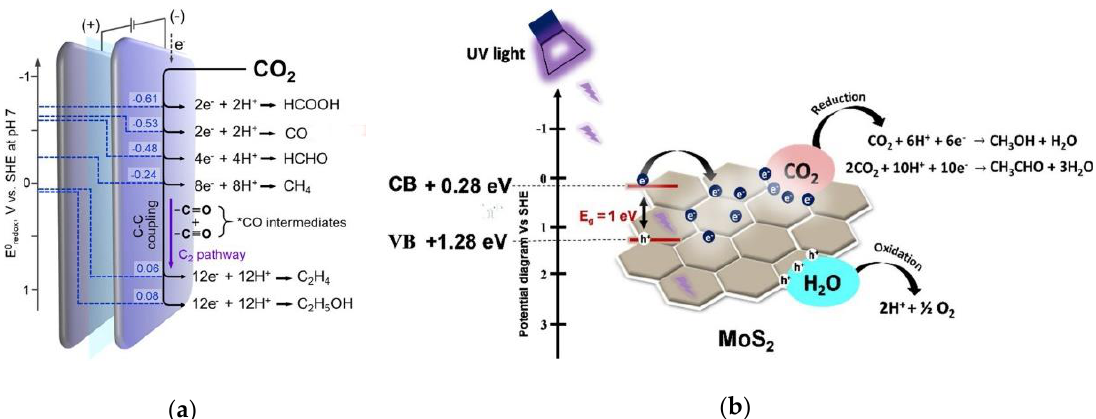
Figure 10. ( a ) Scheme of the electrochemical conversion of CO 2 into value-added chemicals (Reproduced with permission from [241]. Copyright 2019 CC BY-NC 4.0 John Wiley and Son) and ( b ) general working principle of photocatalyst for CO 2 conversion (Reproduced with permission from [249]. Copyright Elsevier 2019).